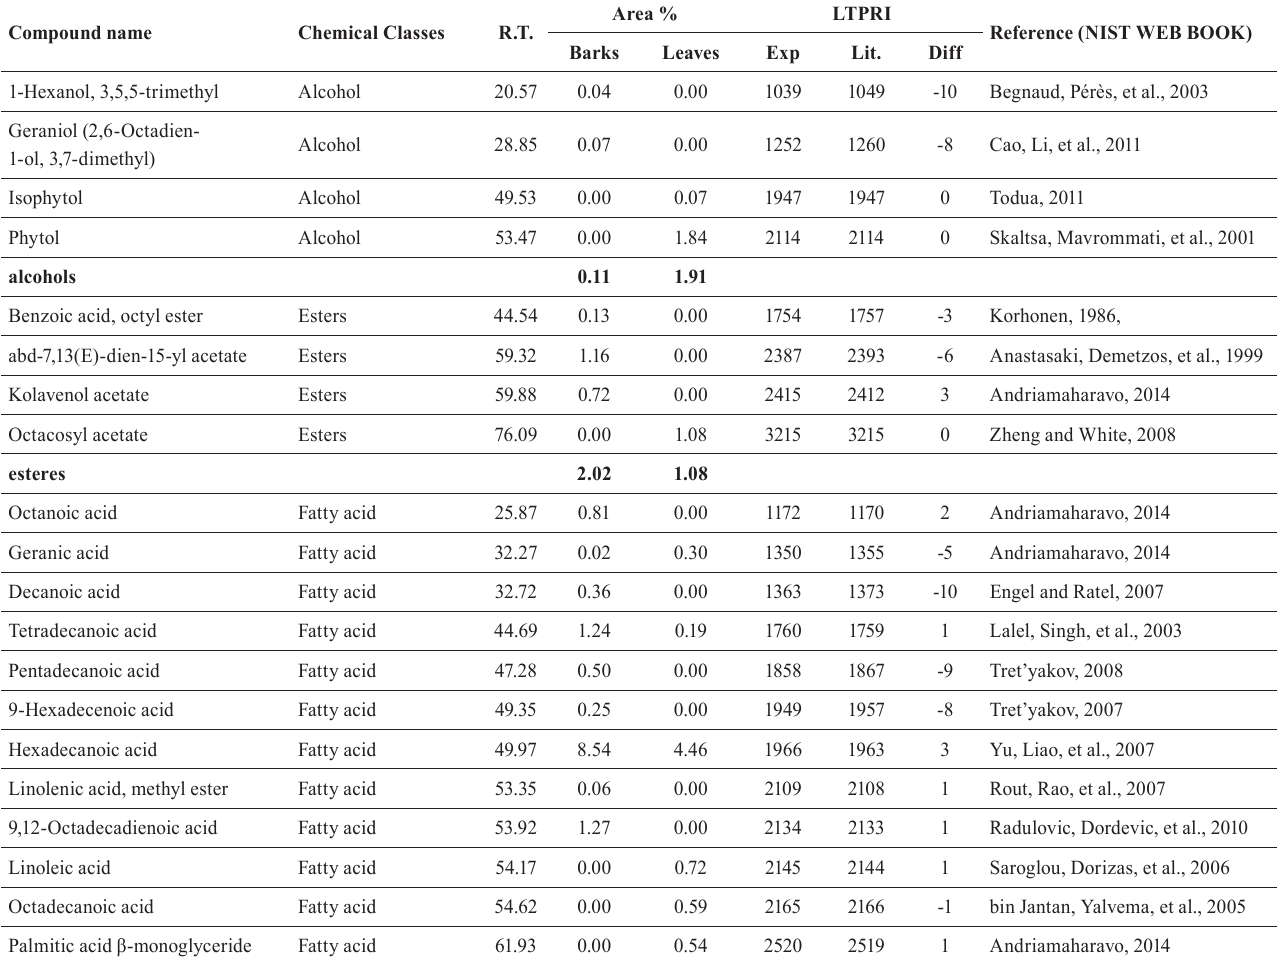
TABLE SI - Tentatively identified compounds in Essential Oils from barks and leaves of Commiphora Leptophloeos by